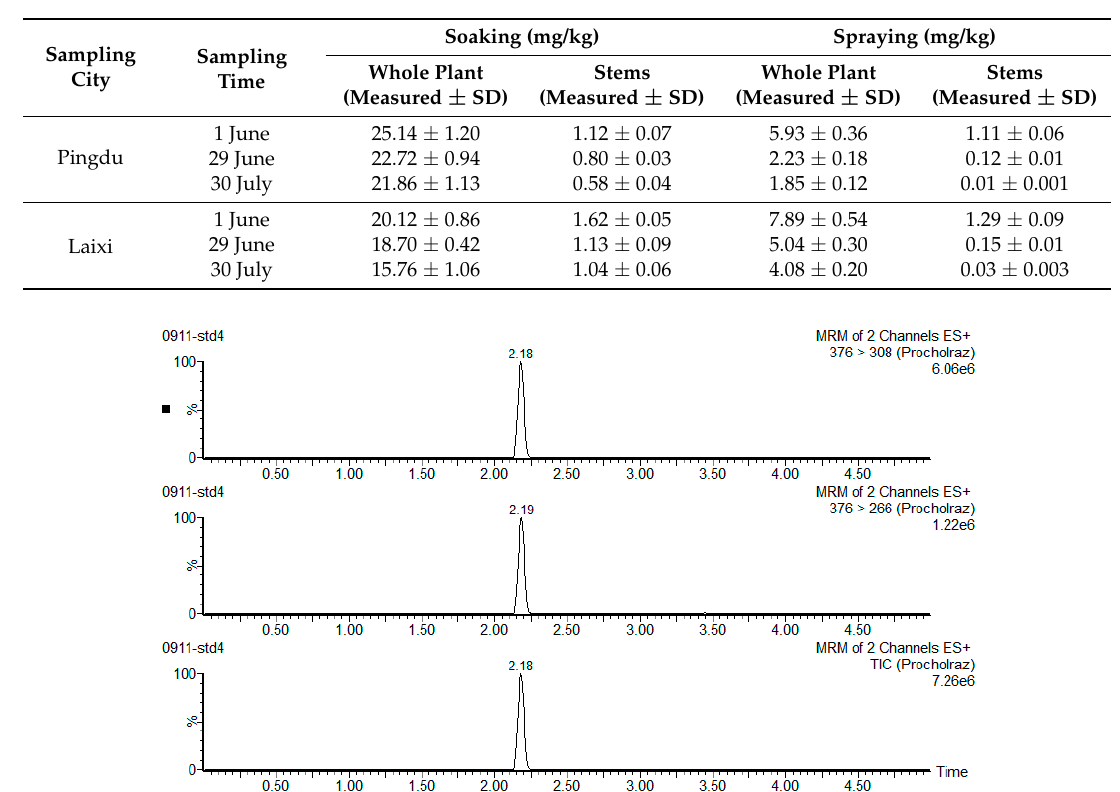
Figure 1. An example of an extracted multiple reaction monitoring mode (MRM) chromatogram of a garlic sprout sample, indicating the presence of prochloraz.